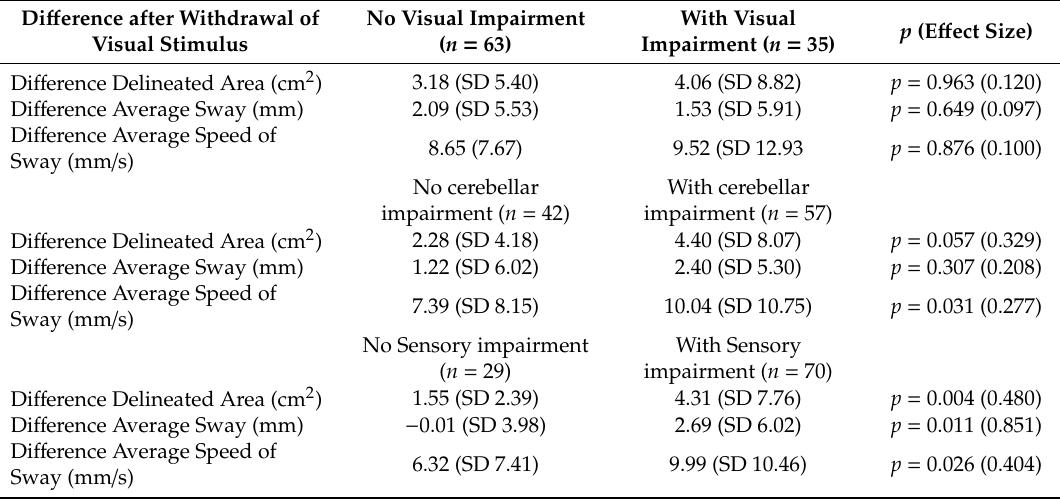
Table 5. Influence of visual feedback in static posturography outcomes in pwMS according to EDSS function